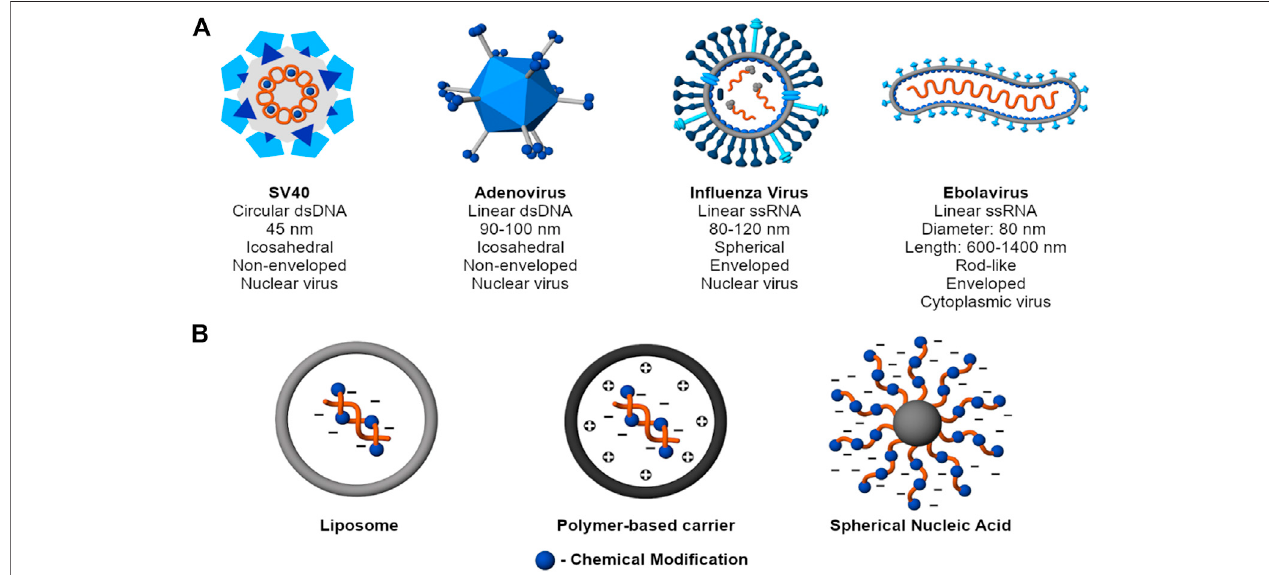
FIGURE 2 | Mechanisms to protect nucleic acid cargo. (A) Examples of common viruses (SV40 - Martini et al. 2007; Adenovirus - Greber et al., 1997; Russel, 2009; In fl uenza Virus - Jamesand Whitley, 2017; Ebolavirus - Beniac et al., 2012; Falasca et al., 2015). Despite structural diversity, viruses collectively protect their genome through charge condensation and encapsulation by a capsid and, for an enveloped virus, an outer lipid membrane. (B) Examples of nonviral nucleic acid delivery systems. Beyond condensation and encapsulation, nonviral carriers also use chemical modi fi cations, self-generated sterics, or a combination of strategies to achieve the same purpose.